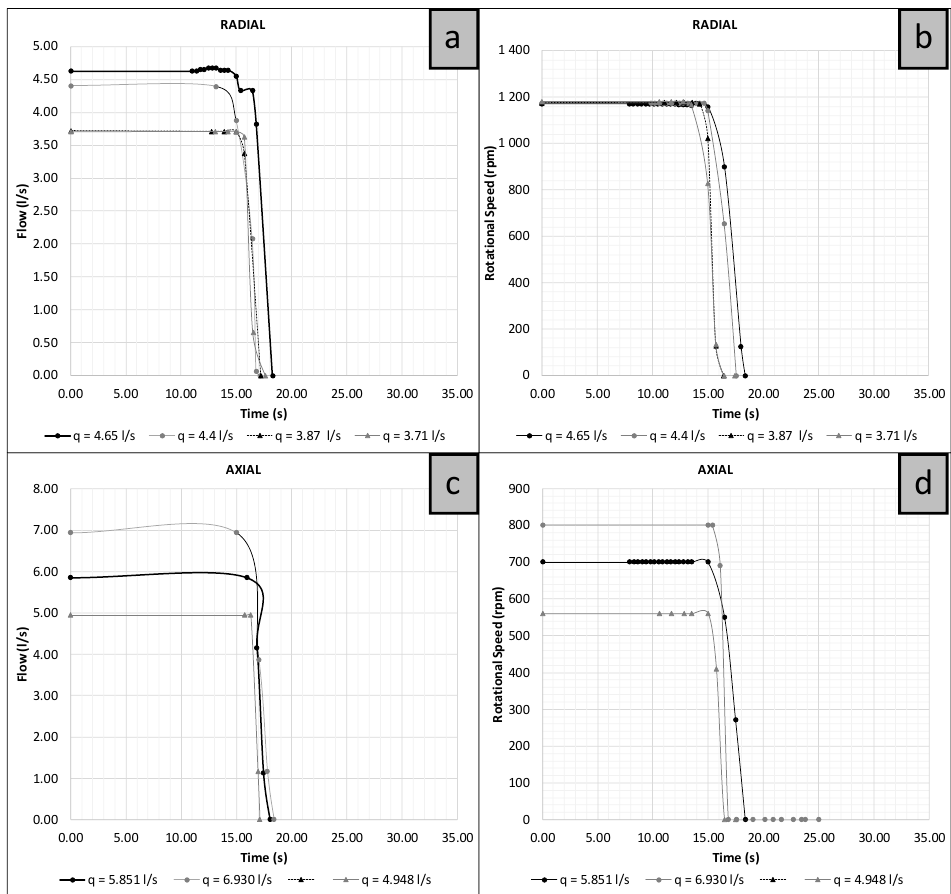
Figure 9. Experimental data recorded for the fast closure of the downstream control valve in radial and axial turbine machines. ( a ) flow for radial machine ( b ) rotational speed for radial machine ( c ) flow for axial machine ( d ) rotational speed for axial machine.